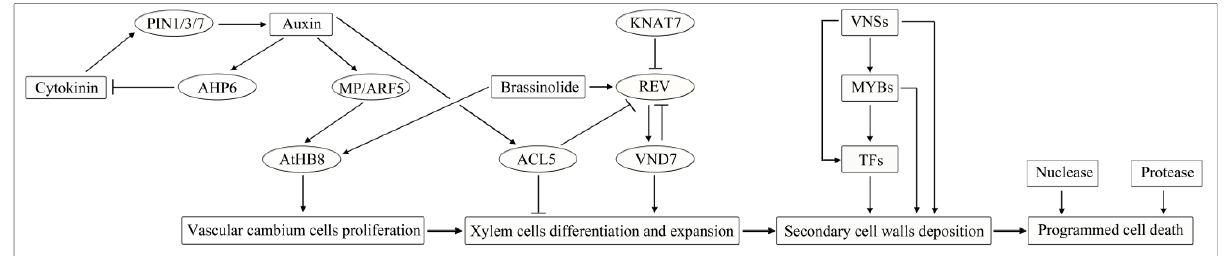
Figure 1. Developmental stages of wood formation and characteristic features of each stage. Note: PIN1, auxin eux carrier PIN-FORMED1 protein; MP/ARF5, the auxin-responsive transcription factor (TF) AUXIN RESPONSE FACTOR 5/MONOPTEROS; AtHB8, ARABIDOPSIS THALIANA HOMEOBOX 8; AHP6, an auxin that positively regulates the expression of an inhibitor of CK signaling; RVE, one of five HD-ZIP III genes in Arabidopsis thaliana ; KNAT7, KNOTTED-LIKE HOMEOBOX OF ARABIDOPSIS THALIANA 7; ACAULIS5 (ACL5), encodes a thermospermine synthase. Solid arrows and flat-headed arrows represent positive and negative transcriptional regulation, respectively. Referred to [23–26].